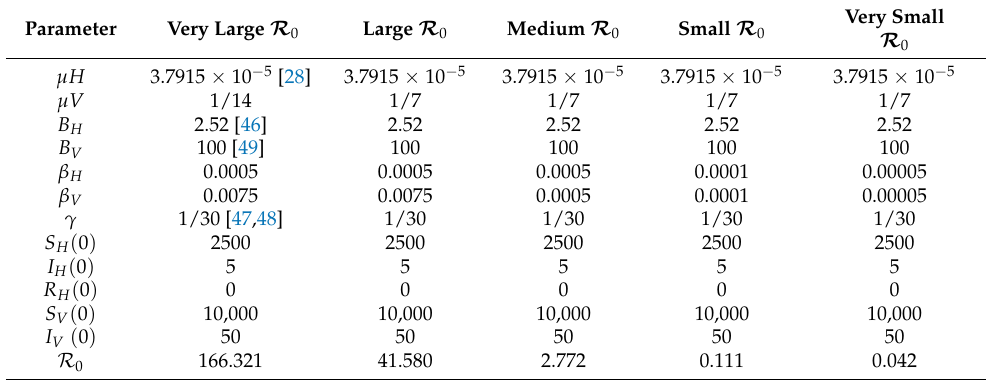
Table 1. Parameter values used in the numerical